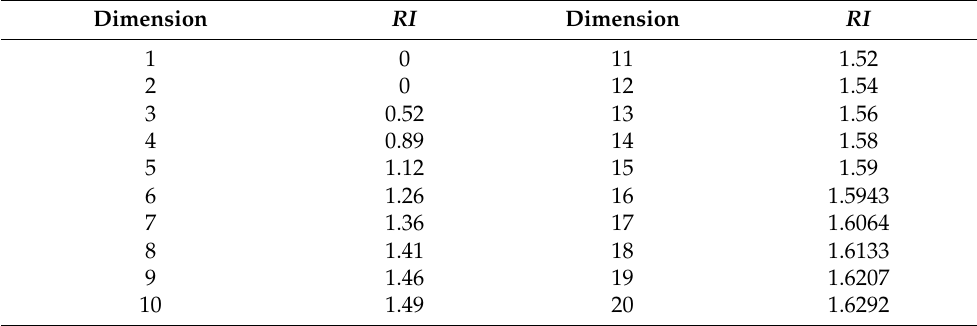
Table 3. Values of RI .